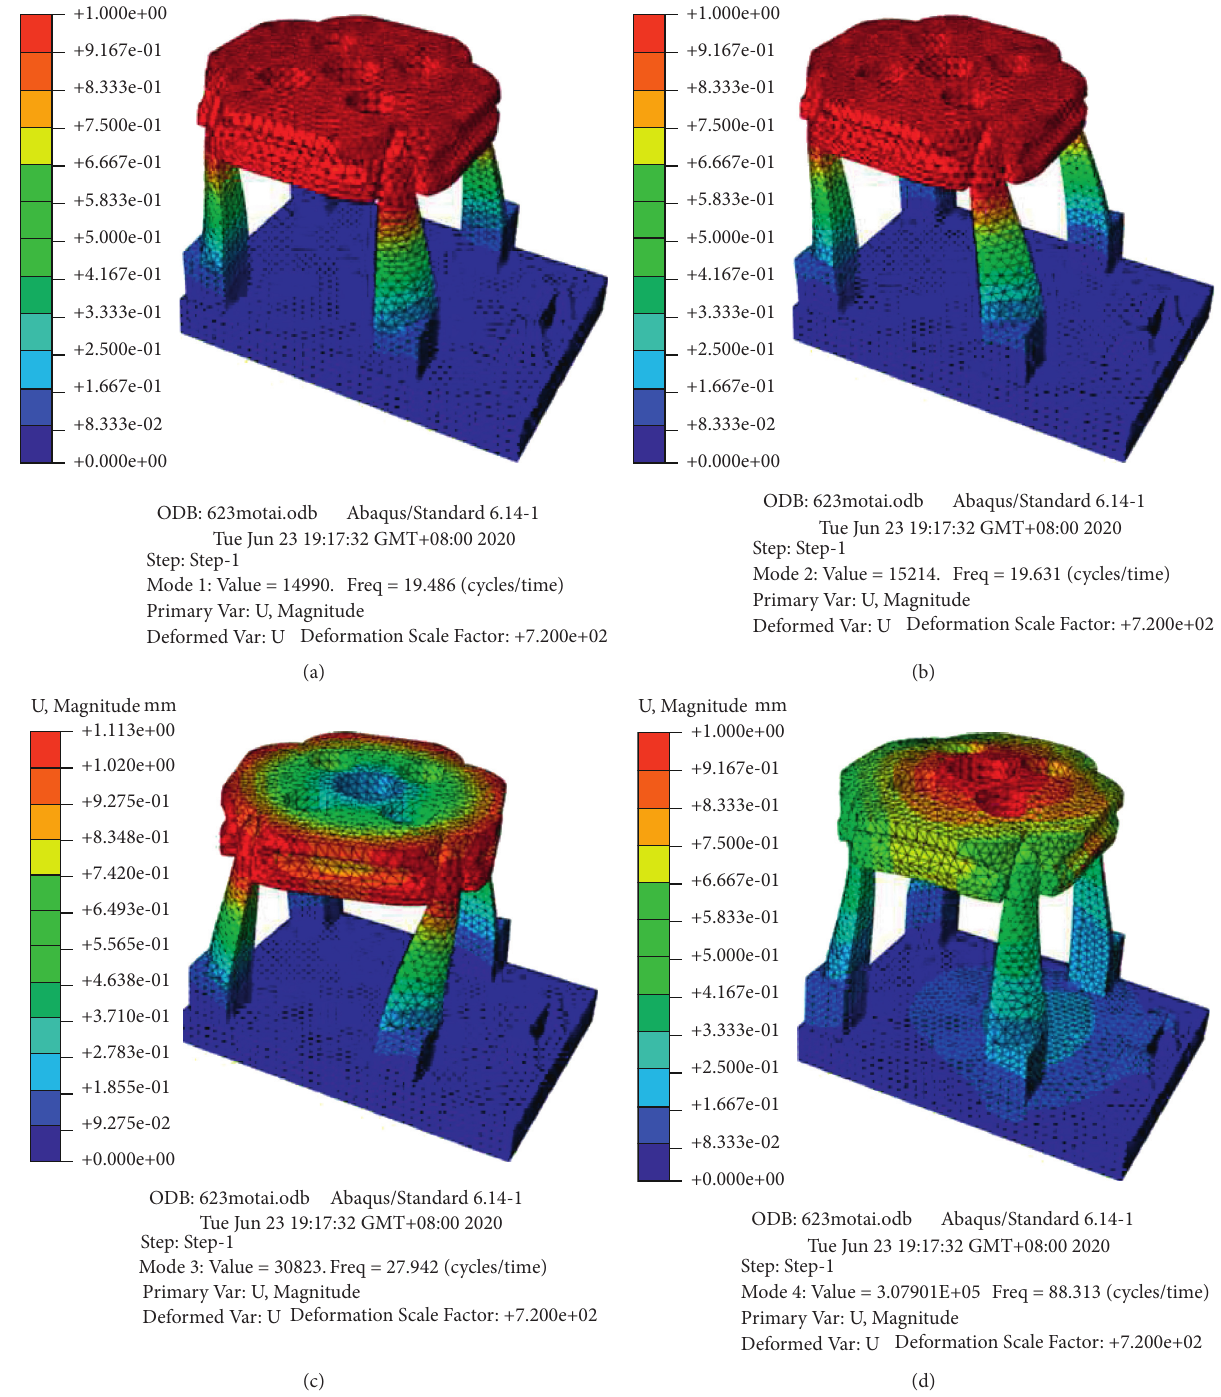
Figure 9: Modal analysis results of compression-shear test machine frame after optimization. (a) First-order mode. (b) Second-order mode. (c) Third-order mode. (d) Fourth-order